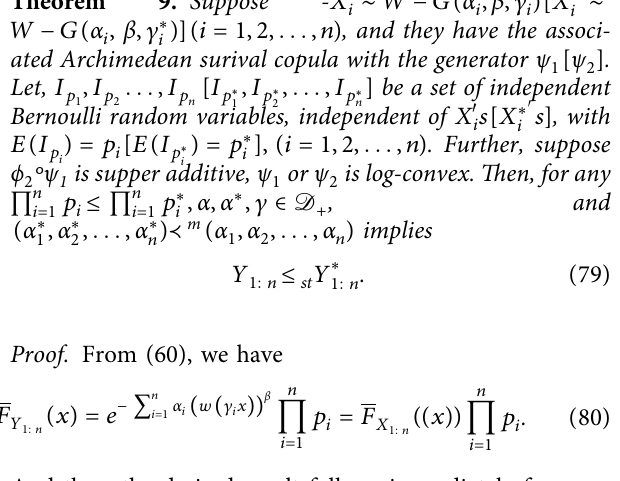
( x ) − F ( x ) ≥ 0, for all x � − ln u Y 1 : 4 1 : 4 Y ∗ ≤ , which coincides with the 1 : 4 st 1 : 4